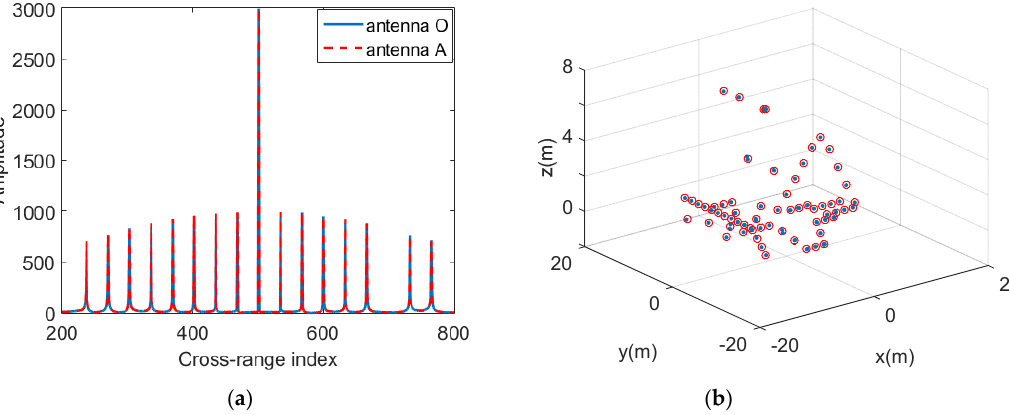
Figure 8. Imaging results after image registration. ( a ) ISAR images at y = 0 of antenna O and antenna A . ( b ) InISAR imaging results.